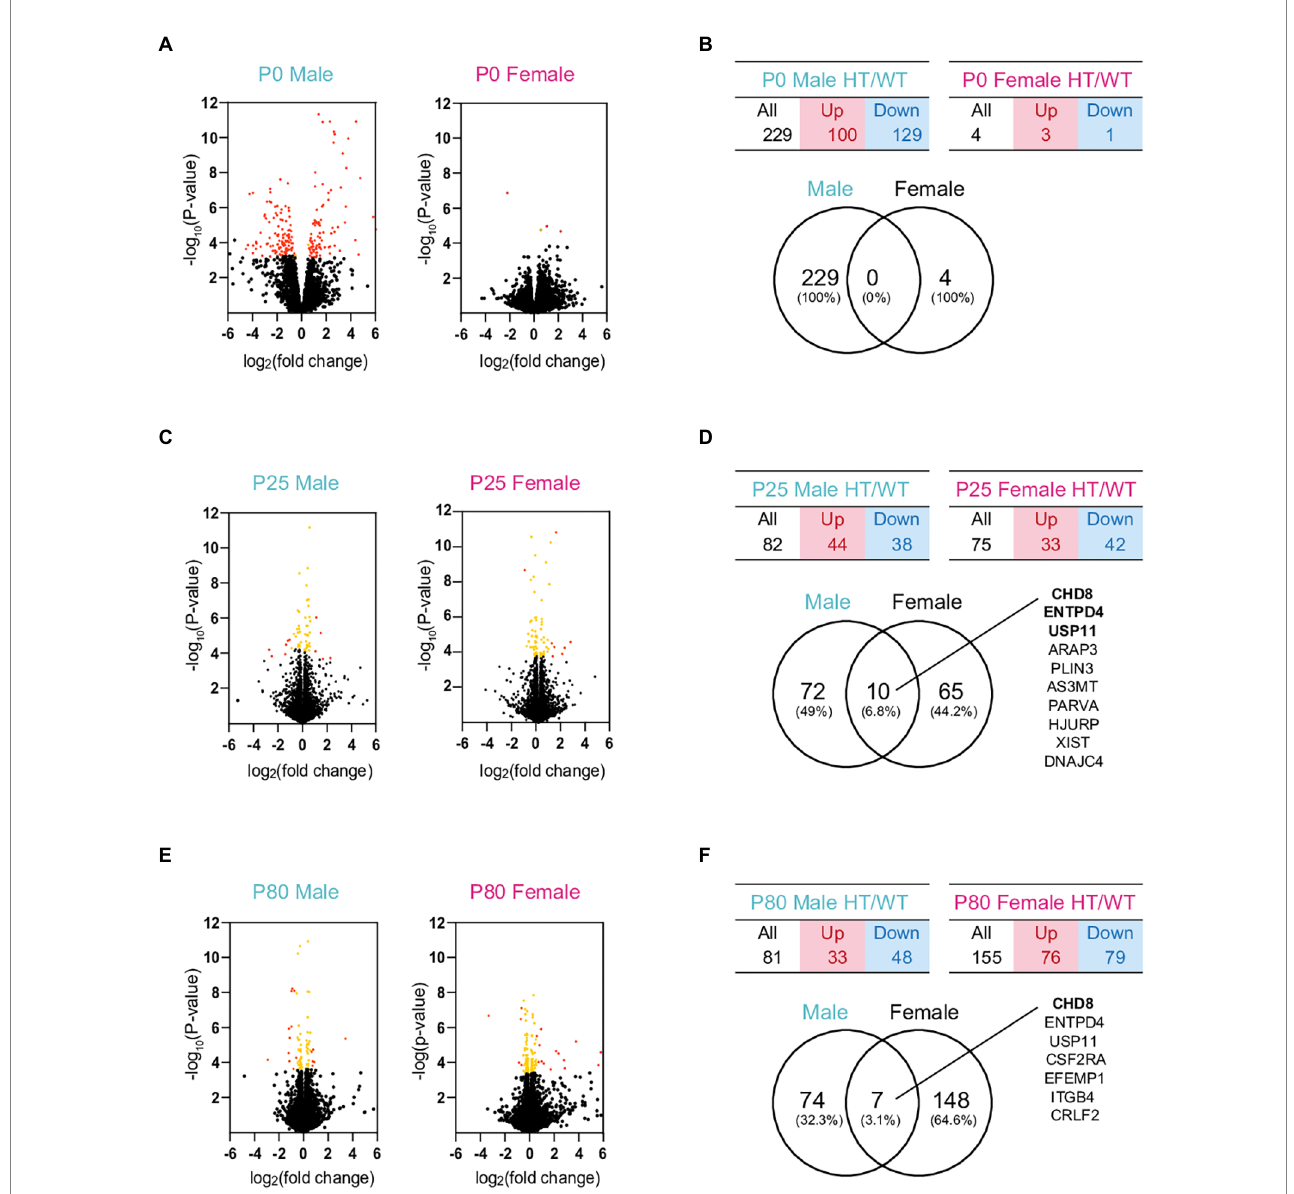
FIGURE 3 DEG analyses of RNA-Seq results from P0, P25, and P80 male and female HT/WT transcripts. (A–F) Volcano plots, tables, and Venn diagrams summarizing the DEGs from P0, P25, and P80 male and female HT/WT transcripts. Orange, genes with adjusted p -value < 0.05; red, genes with adjusted p -value < 0.05 + |FC| > 1.5 (see Supplementary Table S3 for further details on DEGs). Note that the number of overlapping DEGs between males and females is